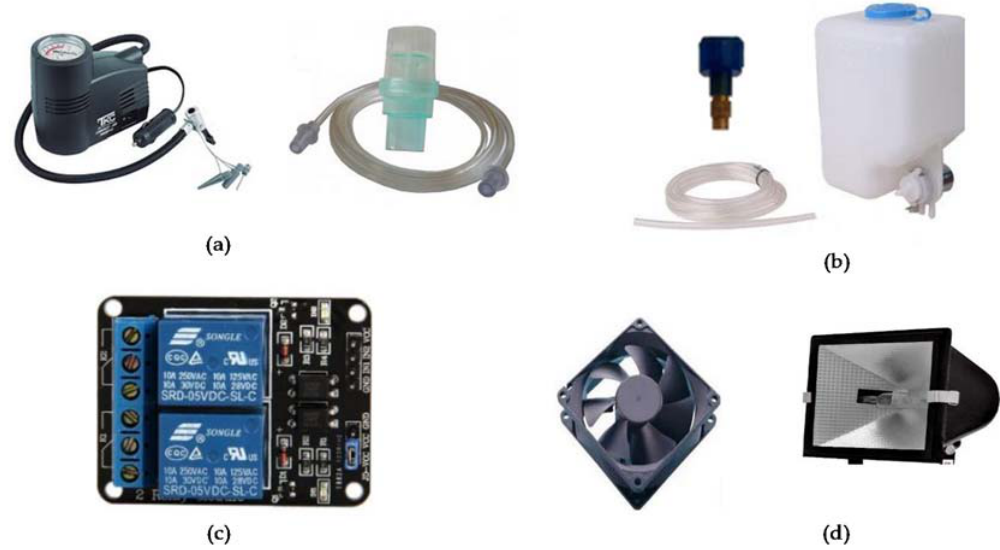
Figure 4. Final control elements. ( a ) The nebulization system; ( b ) the irrigation system; ( c ) the Arduino two ‐ channel relay module; ( d ) the extractor and halogen lamp.